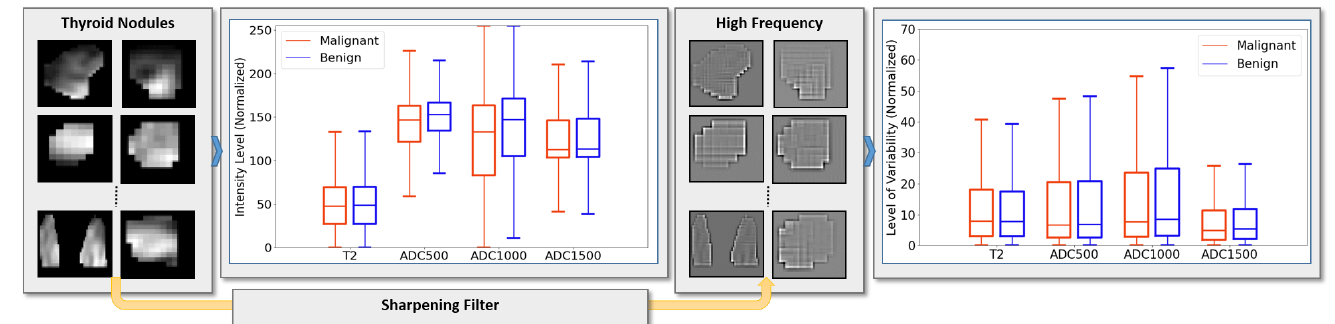
Figure 1. Illustrative diagram of the preliminary statistical study performed on our dataset. A high-pass Laplacian spacial filter was applied to the images to estimate intensity variation at the pixel level. Following that, statistical analysis was performed to calculate the mean difference between malignant and benign nodules.